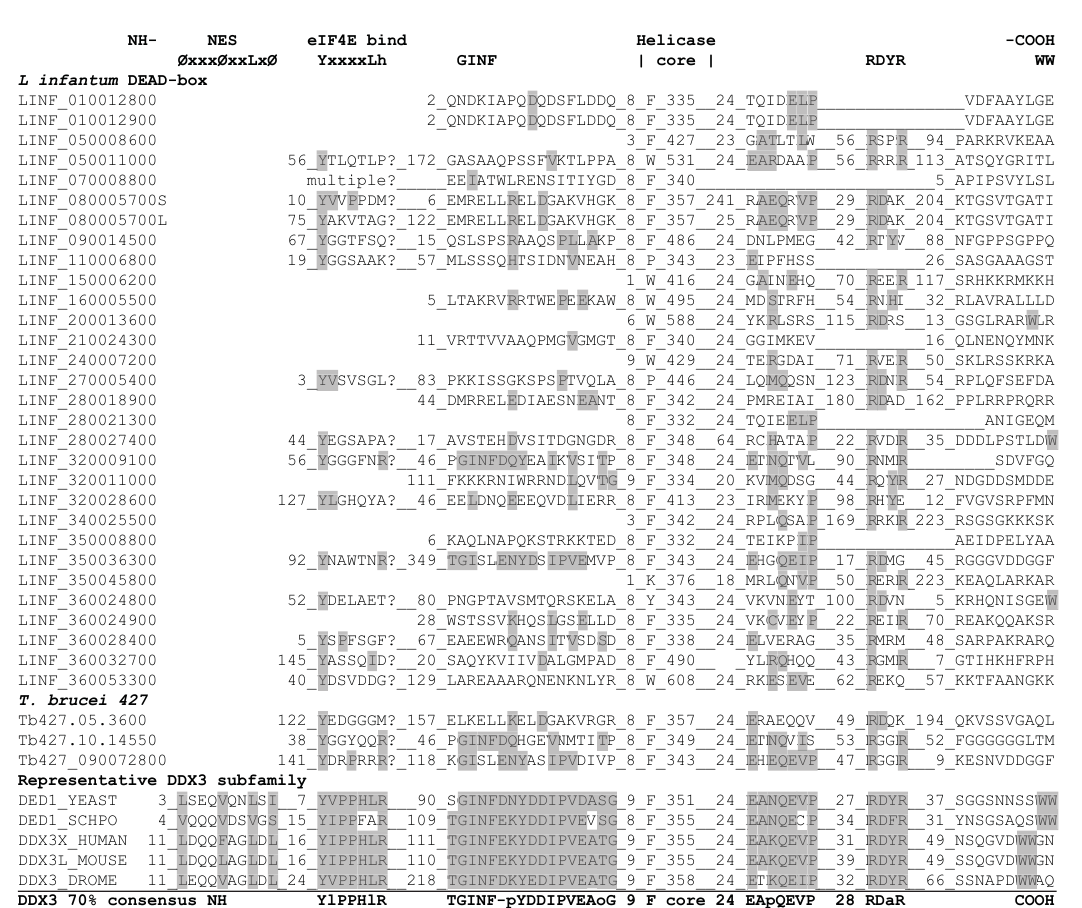
Figure 3. Alignment of the helicase flanking sequences of DEAD-box proteins of Leishmania . The consensus for the Ded1/DDX3 subfamily is as described in Figure 2, where it signifies a negatively charged residue. Aliphatic groups (I, L, V) are largely interchangeable, and we considered them equivalent in this figure. Ø denotes amino acids M, V, I, L, F, or W. The conserved sequences listed as characteristic of this subfamily (top) was based on previous work [77,78]. Distinctive residues for this subfamily are shown in gray. Note that the DDX3 70% consensus was based on a subset of the original sequences as indicated in Figure 2; hence it is not representative of the full diversity of annotated Ded1/DDX3 sequences obtained in Blasts.